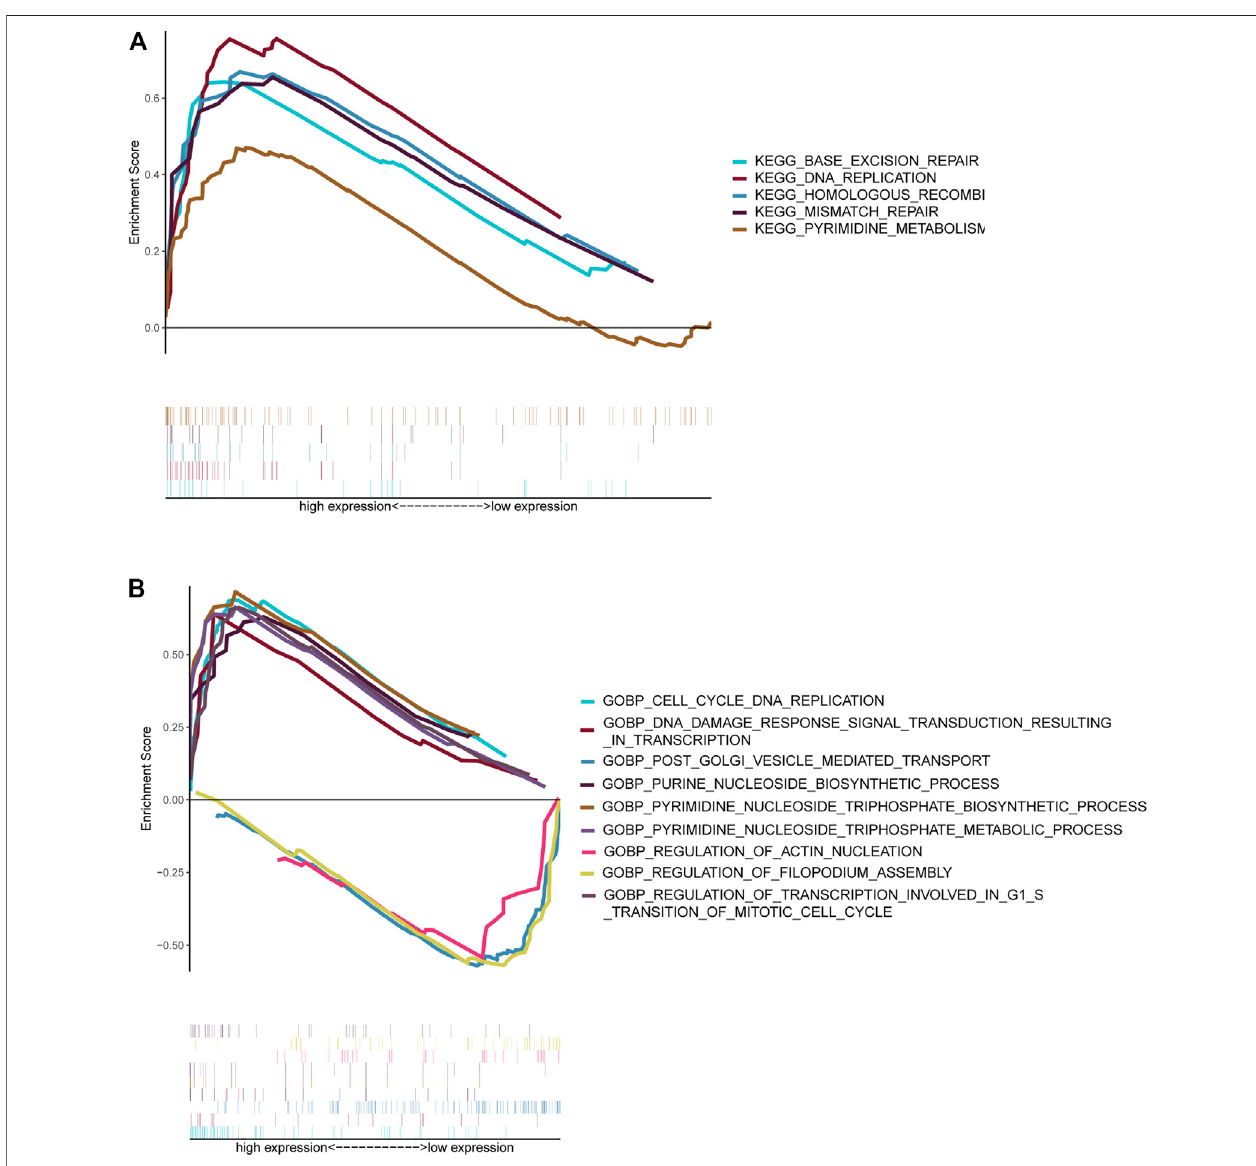
FIGURE 7 | Gene set enrichment analysis. Gene sets enriched in the high-risk score group (A, C) . Gene sets enriched in the low-risk score group (B, D) . Nom p -value < 0.05 was deemed signi fi cant.